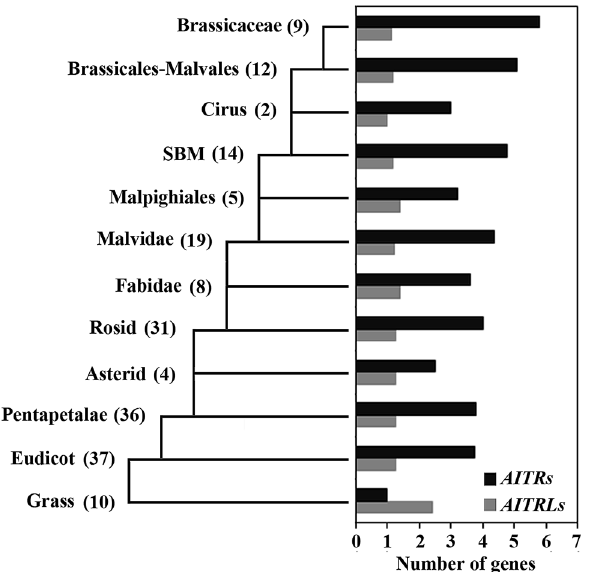
Figure 7. Changes of AITRs and AITRLs gene numbers during evolution of angiosperm. Numbers of AITRs and AITRLs genes were obtained by using AITR5 and AITRL respectively, for “Gene Ancestry” assays on phytozome. Average gene numbers per plant specie were calculated for different catalogs of angiosperm. Numbers in the brackets indicate total plant species available on phytozome in the indicated